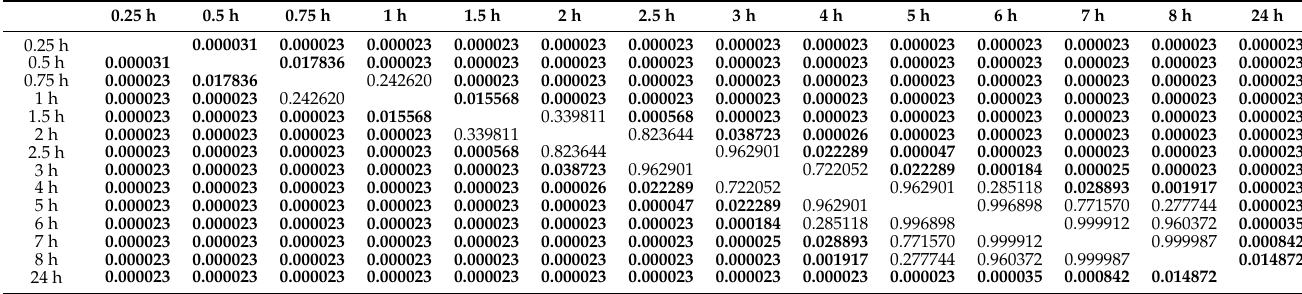
Table A7. Significant differences for the EMC variable for the effect of climatic chamber operation time (CCOT) according to Tukey’s test (HSD) for mandarin peels.